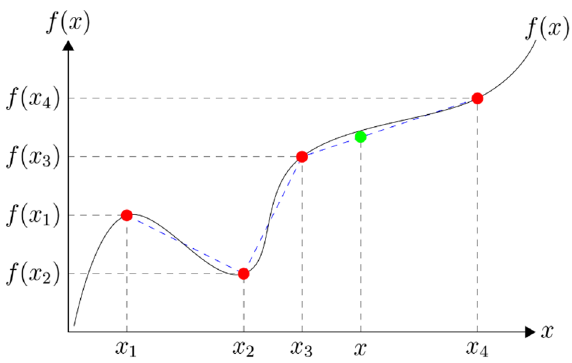
Fig. 8 SOS2 models in one